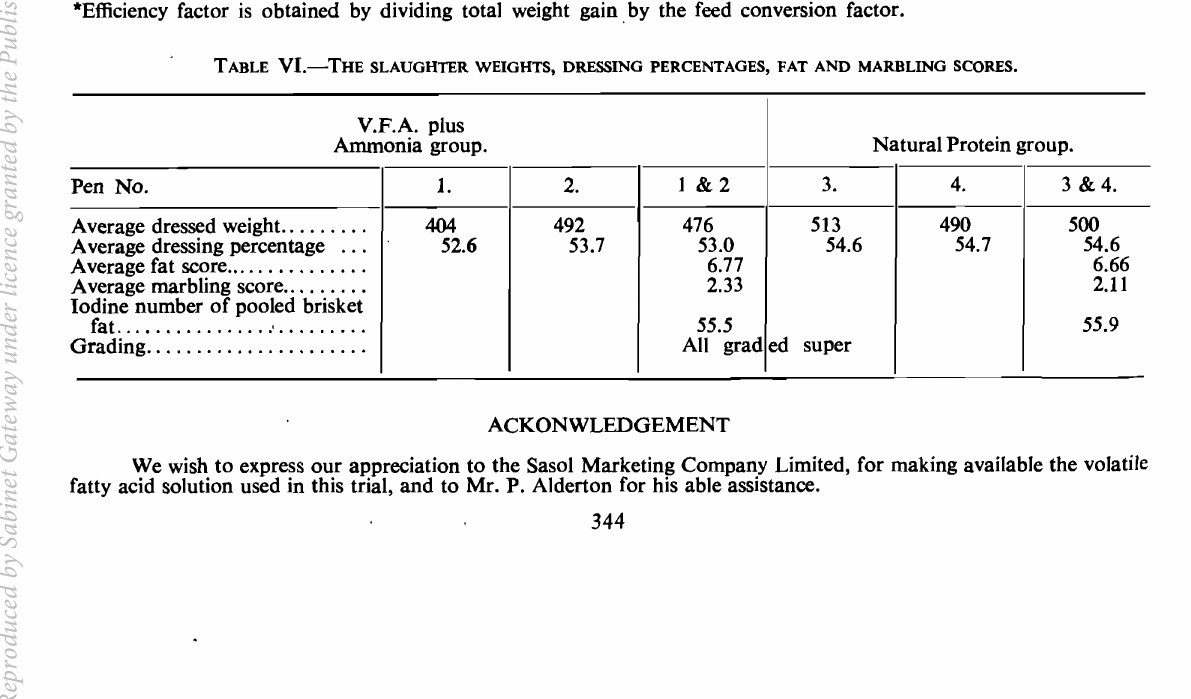
*Efficiency factor is obtained by dividing total weight gain, by the feed conversion factor.